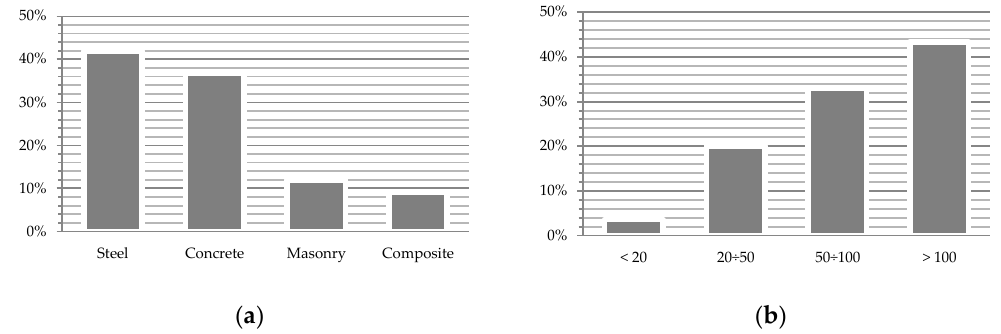
Figure 1. Statistics of railway bridge infrastructure; ( a ) according to construction material specifications; ( b ) according to the number of years in operation (based on [1]).